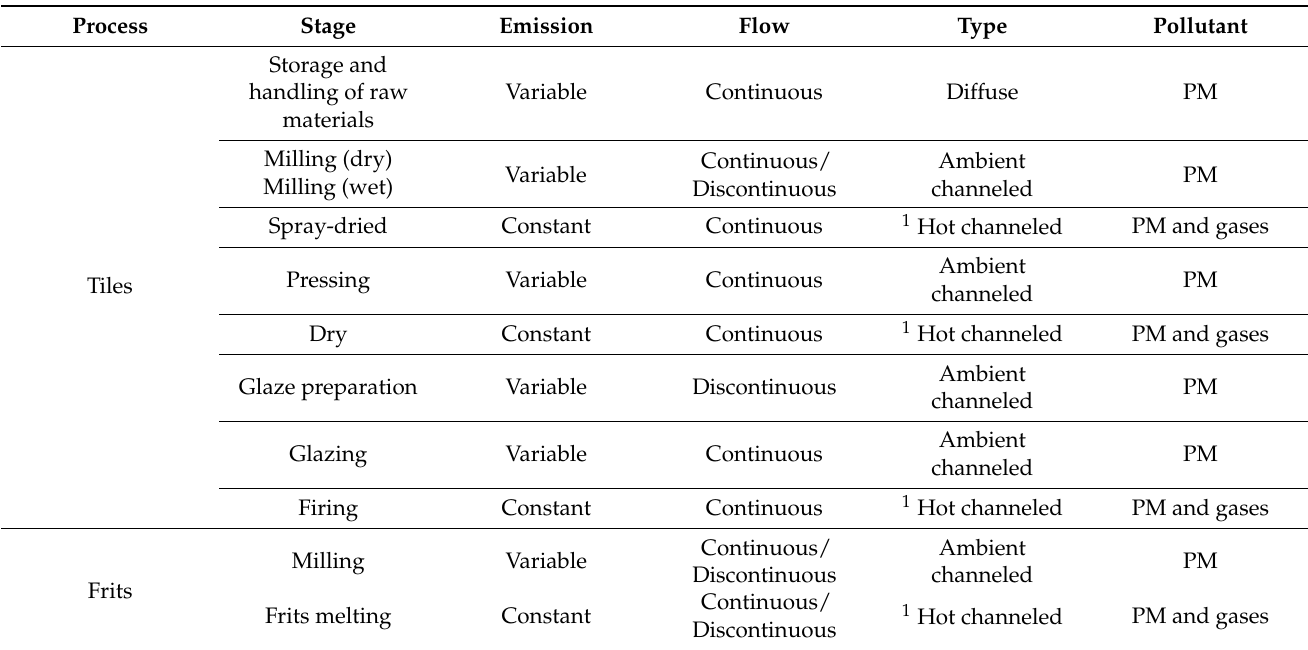
Table 1. Ceramic process emissions.